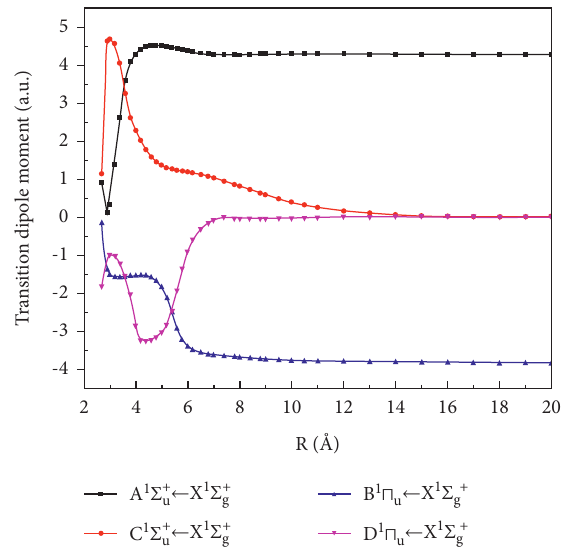
Figure 2: Transition dipole moment curves for allowed transition of Yb 2 investigated in